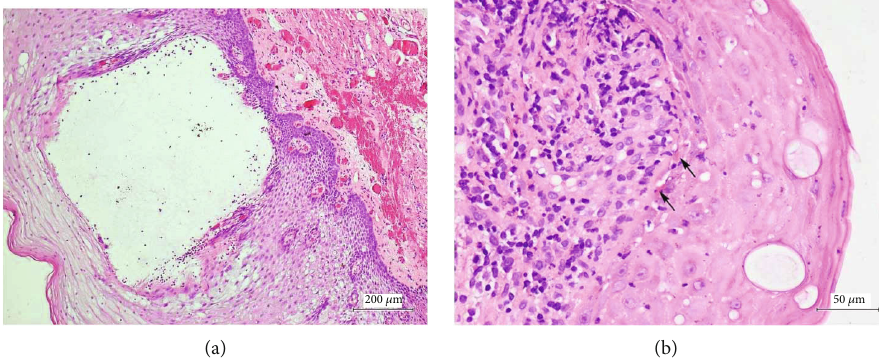
Figure 3: Histopathologic features of super fi cial mucoceles illustrated an intraepithelial vesicle containing mucin pool with scattered lymphocytes (original magni fi cation, 100x) (a). Histopathologic features of OLP showed basal cell degeneration with subjacent in fl ammatory cell in fi ltrate. The arrows indicate civatte bodies (original magni fi cation, 400x)